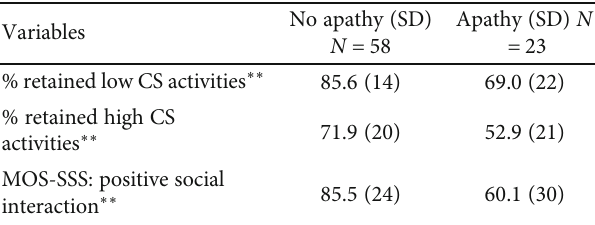
Table 7: Mean scores and standard deviations (in parentheses) for those with and without clinically signi fi cant